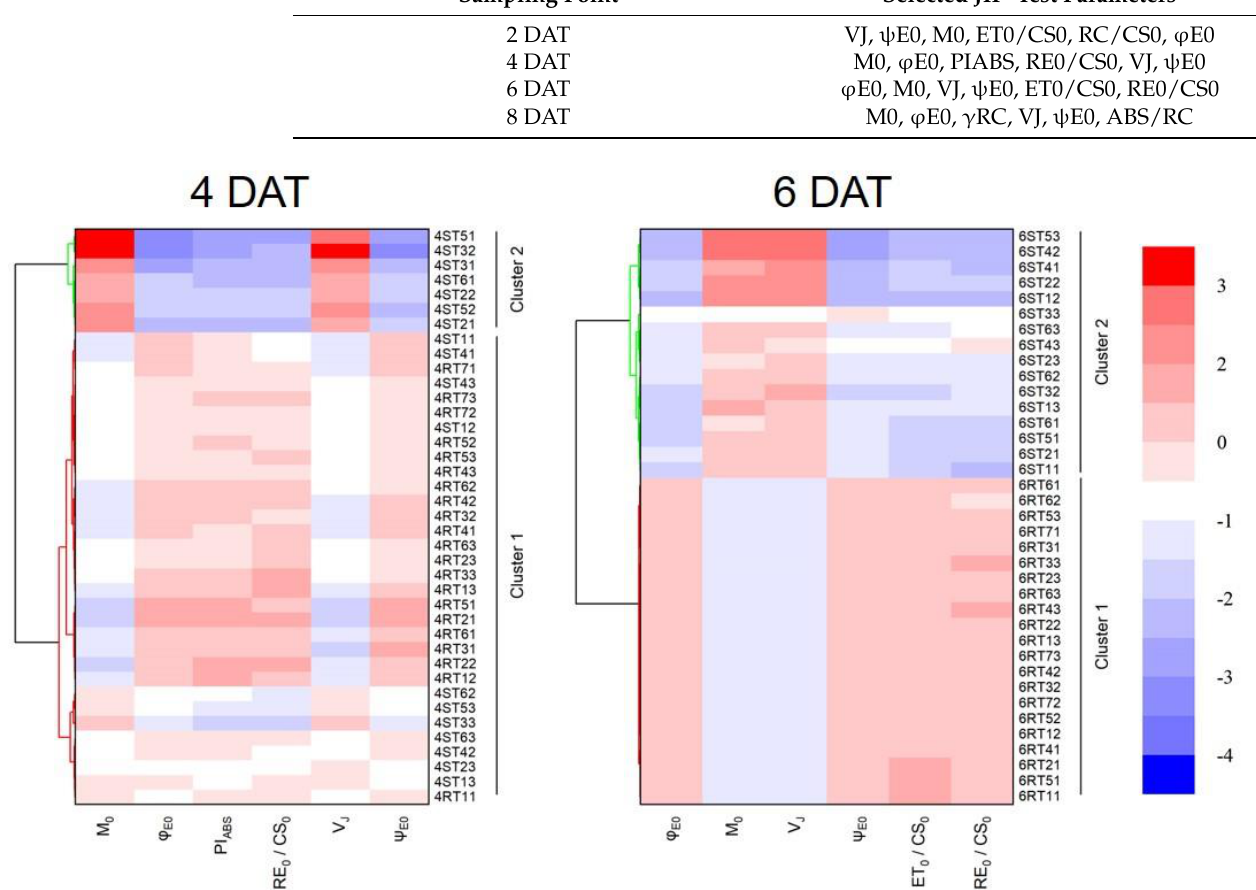
Figure 8. Clustering of samples using the Ward.D linkage algorithm with selected features of PCA loading at 4 and 6 days after treatment (DAT).